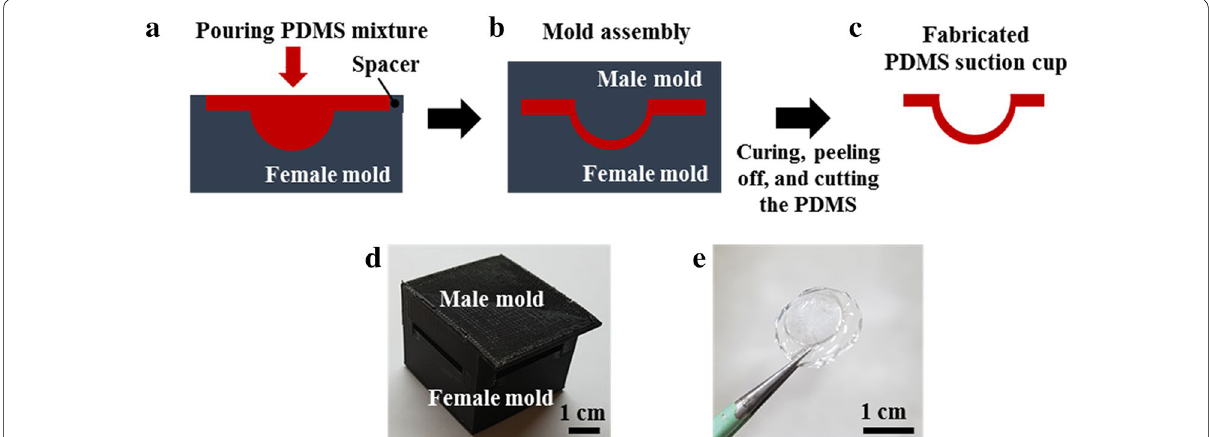
Fig. 1 Fabrication process of the PDMS suction cup, photographs of the 3D printed mold, and fabricated suction cup. a – c The PDMS mixture is poured in the 3D printed mold, cured, peeled off from the mold, then cut by a razor blade. d 3D printed molds for the PDMS suction cup fabrica- tion. e Fabricated PDMS suction